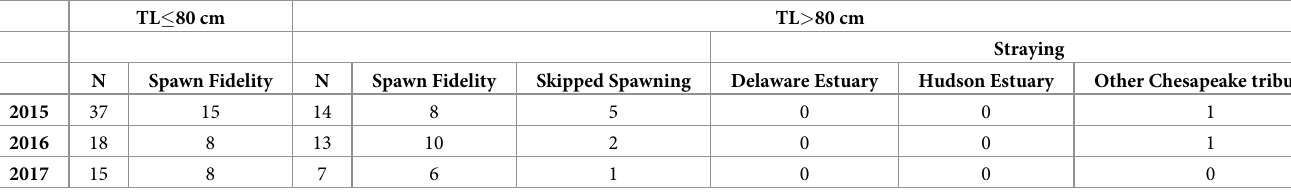
Table 3. Spawning site fidelity, straying and skipped spawning by study striped